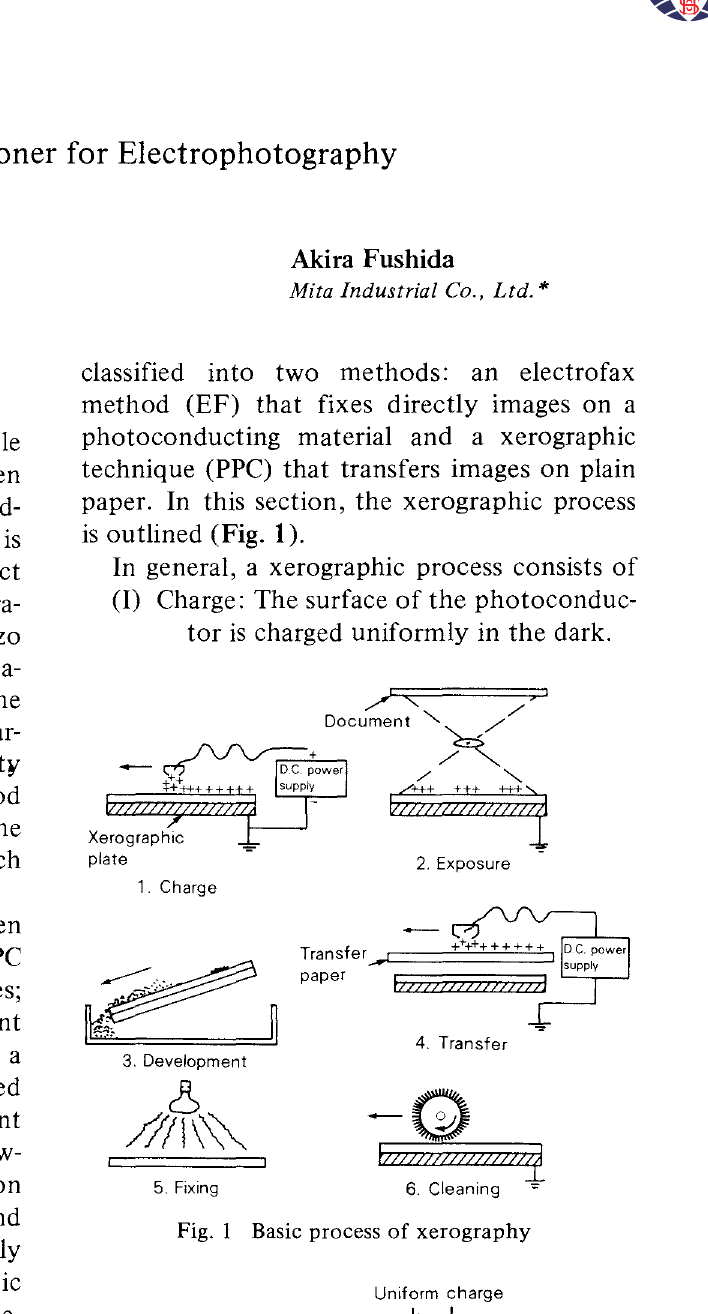
Fig. 1 Basic process of xerography